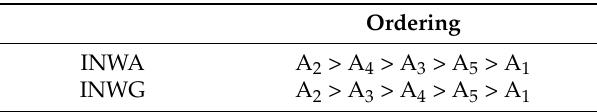
Table 6. Order of the emerging technology